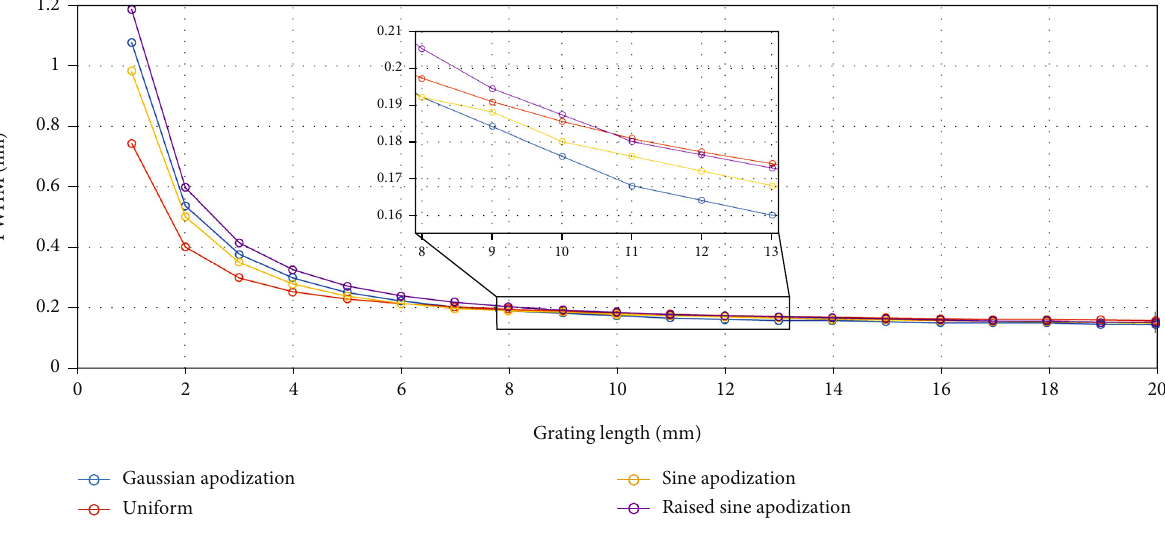
Figure 11: The full width at half maximum versus the grating length of FBG. Table 1: Optimal FBG grating parameters for raised sine, Gaussian apodization, and sine apodization with modulation index 1 × 10 − 4 , 1 : 5 × 10 − 4 , and 2 × 10 − 4 . Apodization